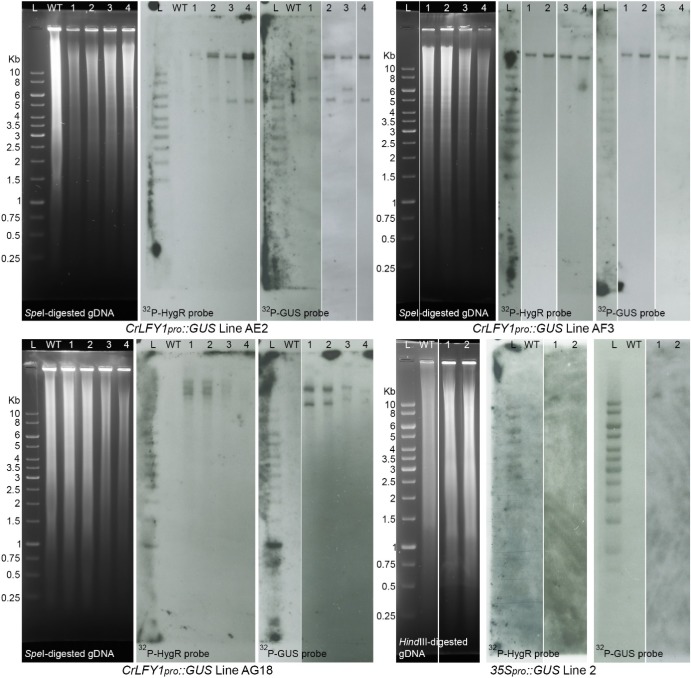
DNA gel blot analysis of CrLFY1pro::GUS and 35Spro::GUS transgenic lines.CrLFY1pro::GUS lines AE2, AF3, and AG18 were regenerated from three separate bombardments and so are necessarily independent of one another. Genomic DNA was extracted from four T1 sporophytes (arising from the free fertilization of T1 gametophytes) within each line, digested with SpeI and separated on an electrophoresis gel. Genomic DNA from two T1 sporophytes of 35Spro::GUS line two was digested with HindIII. Gel blot analysis of both constructs was performed with the same two probes, hybridizing to the GUS CDS and hygromycin resistance (HygR) CDS, respectively (Figure 4—figure supplement 1). For each full-length CrLFY1pro::GUS T-DNA insertion present in the genome a single insert is predicted to result in unlinked hybridization fragments with minimum sizes of ~2.5 kb (HygR) and ~6 kb (GUS). For 35Spro::GUS, a single fragment with a minimum size of ~5.1 kb is predicted per insertion event for both probes (see Figure 4—figure supplement 1). Gel blot results indicate the presence of one full-length T-DNA insertion in 35Spro::GUS line 2. Based on the hybridization fragments obtained, CrLFY1pro::GUS line AE2 contains two potentially full-length insertions of the CrLFY1pro::GUS cassette and 1–2 insertions of partial fragments, AF3 contains a single potential full length insertion and AG18 contains two potential full length insertions.